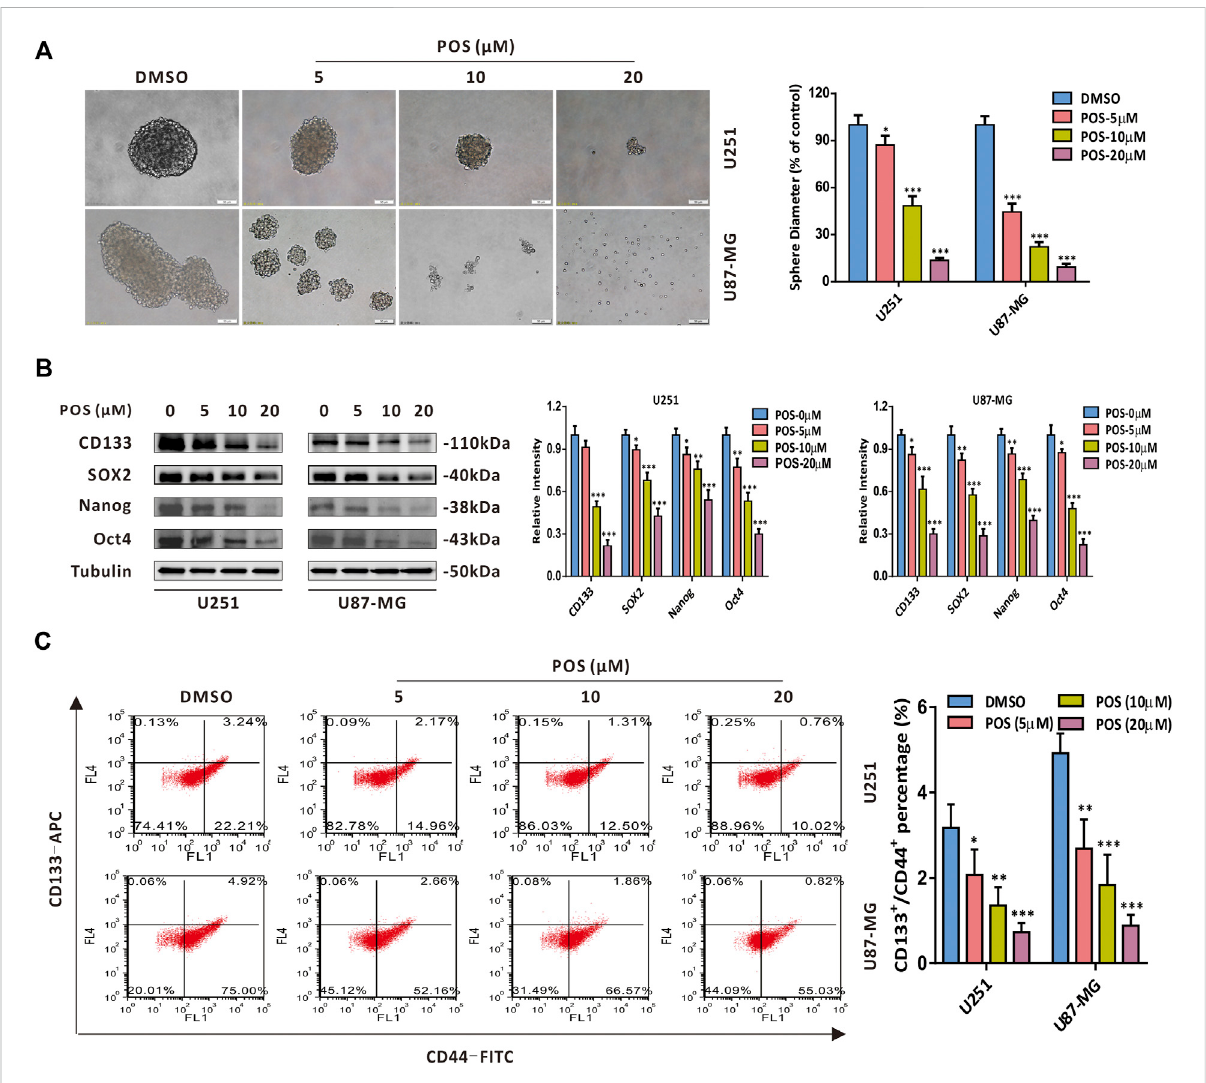
FIGURE 2 POS attenuates CSCs stemness in GBM cells. (A) Self-renewal capacity was detected by asphereformation assay after the cells were treated as indicatedfor2 weeks.Scalebar,50 μ M. (B) ExpressionlevelsoftheCSCsmarkerproteinsCD133,SOX2,NanogandOct4weremeasuredbywestern blotting after the cells were treated as indicated for 24 h. (C) CD44 + /CD133 + subpopulations were monitored by fl ow cytometry after the cells were handled as in (B)